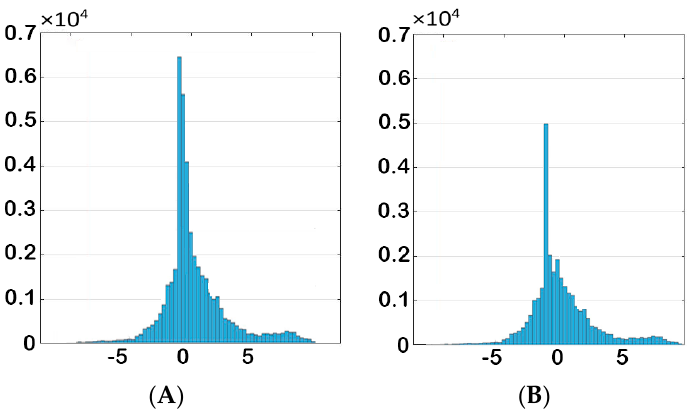
Figure 30. Histogram of y -direction-velocity ( A ) before and ( B ) after elimination.